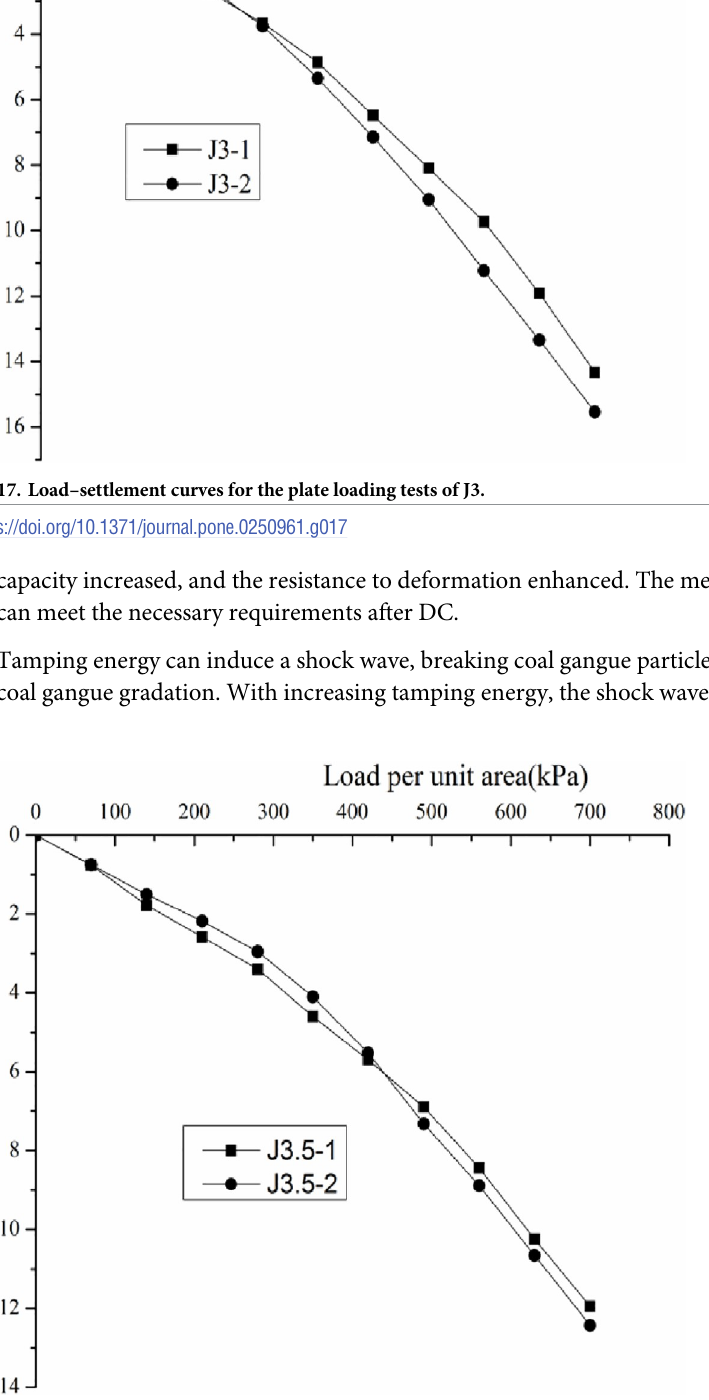
Fig 18. Load–settlement curves for the plate loading tests of